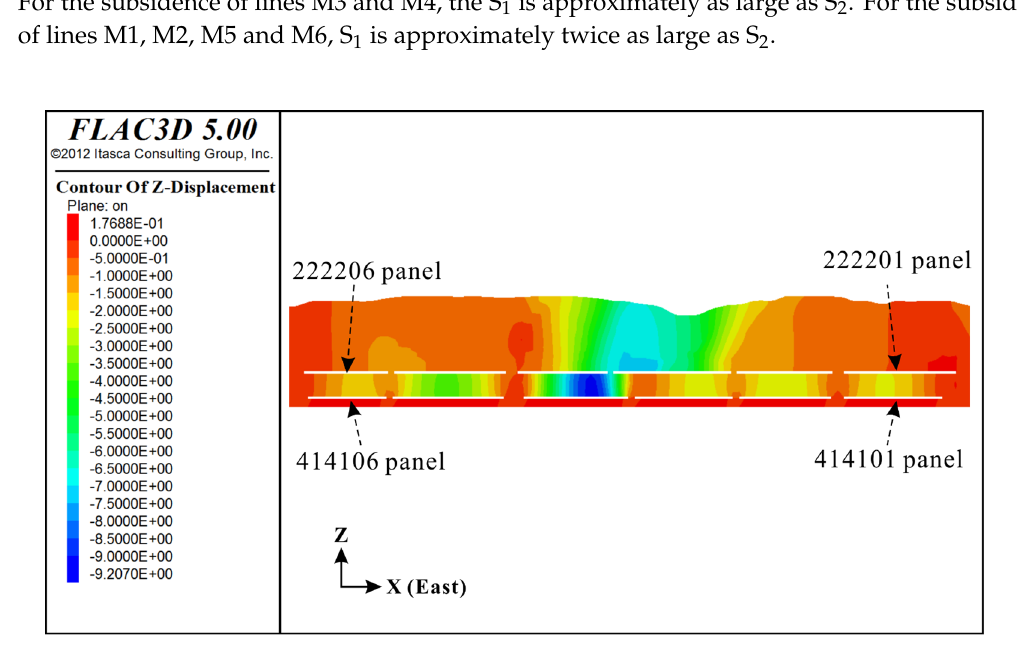
Figure 11. The transverse section (across the mining direction) of the S 1 contour (section I-I is shown in Figure 9).